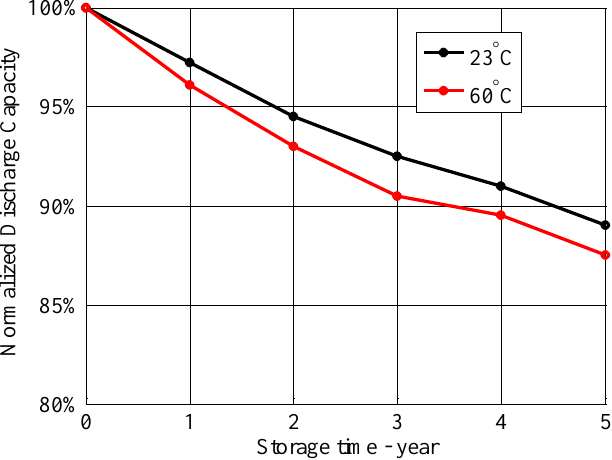
Figure 2. Discharge capacity over storage time at 23 °C and 60 °C